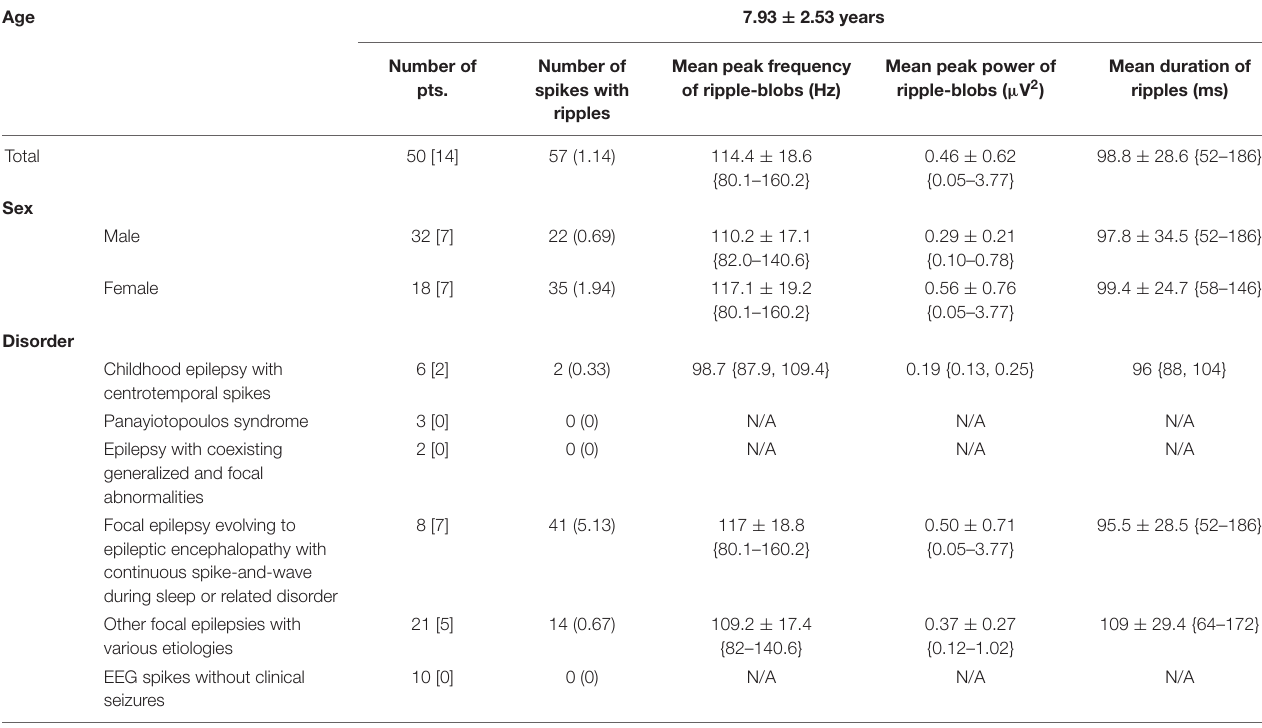
TABLE 1 | Demographic data of the patients.